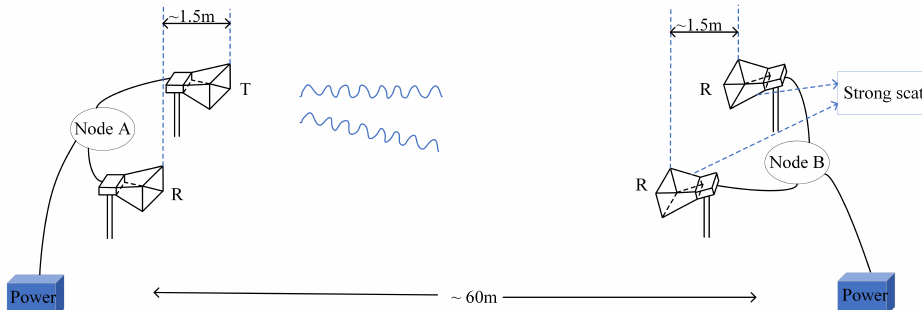
Figure 8. Schematic diagram of the experiment.